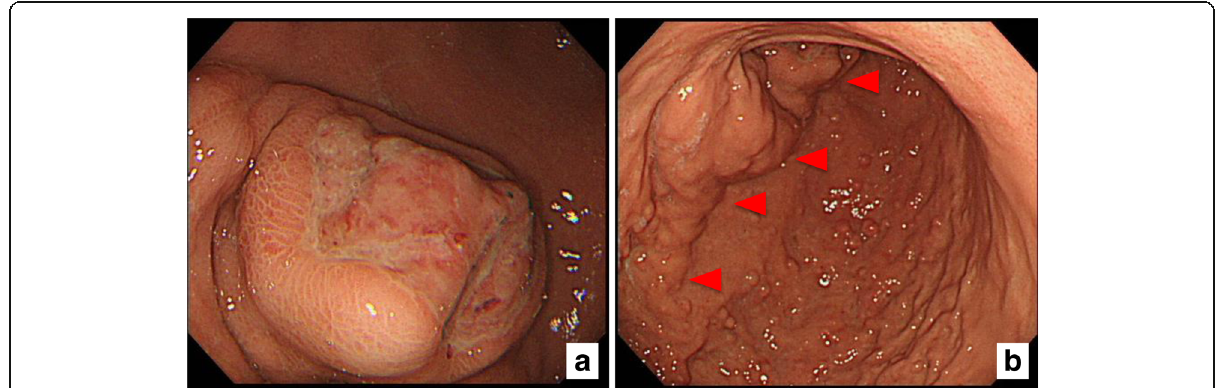
Fig. 1 a , b Findings on upper GI endoscopy. An SMT and ulcer are present on the anterior wall of the lower body of the stomach ( a ). Multiple hyperplastic polyps are seen on the mucosa ( b ). There is no active bleeding from the SMT or ulcer. Red triangle indicates a part of the thickening